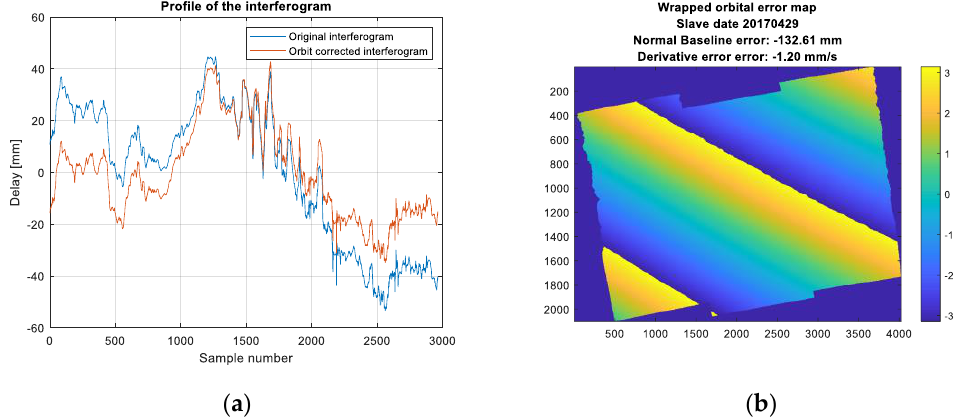
Figure 12. ( a )Profile of an APS maps before (blue) and after (red) orbit trend correction. ( b ) Wrapped and geocoded orbital plane corrected in the interferometric phase.